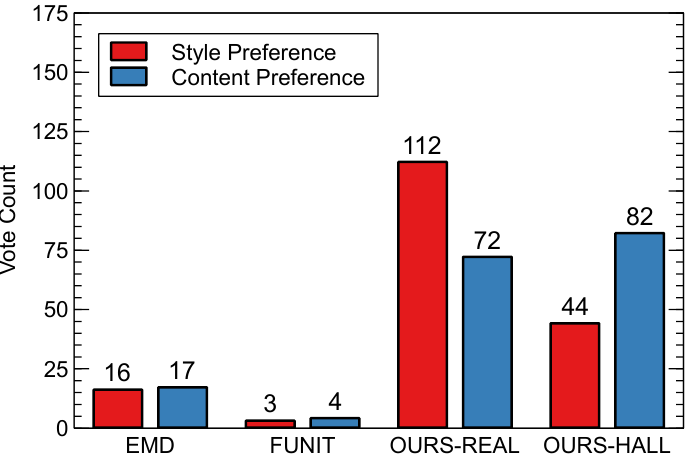
Figure 16. Examples of English unseen font style generation. Red boxes represent ‘bad’ results, blue boxes ‘not bad’ results, and no box ‘good’ results. The last two columns show some failure cases, so we did not mark any box here.